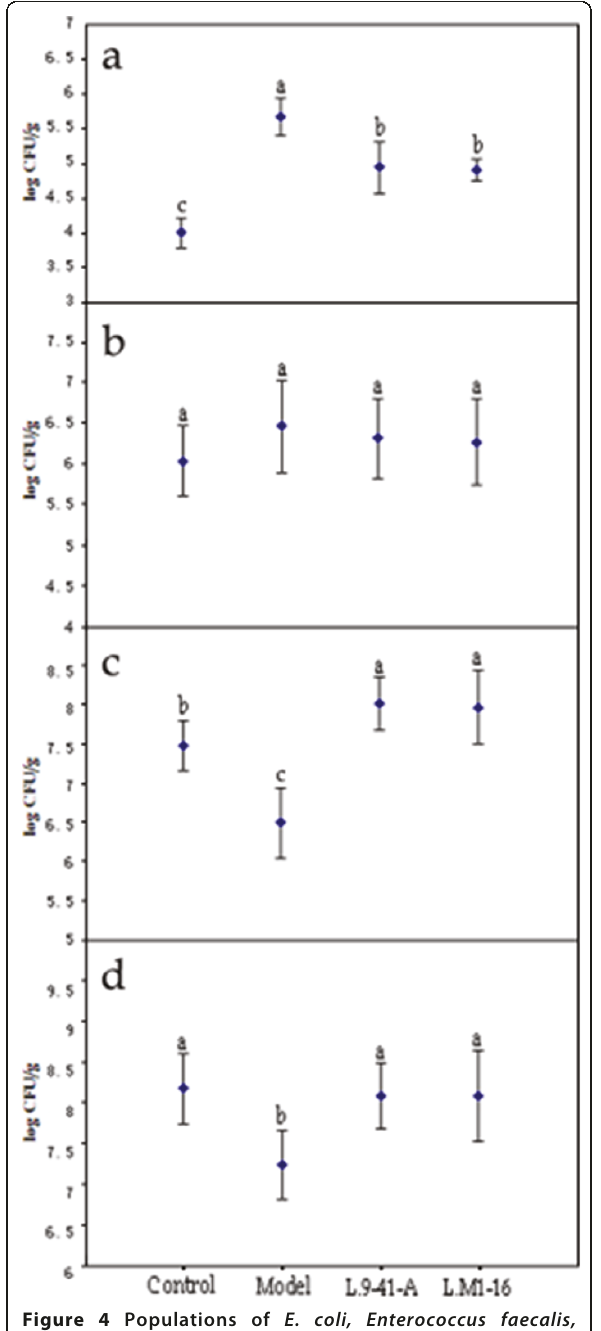
Figure 4 Populations of E. coli, Enterococcus faecalis, Lactobacillus , and Bifidobacterium in rat cecums in the four groups . Control group: normal diet; model group: high-cholesterol diet; L .9-41-A group: high-cholesterol diet + L. plantarum 9-41-A; L . M1-16 group: high-cholesterol diet + L. fermentum M1-16. a: Counts of E. coli colonies. b: Counts of Enterococcus faecalis colonies. c: Counts of Lactobacillus colonies. d: Counts of Bifidobacterium colonies. a,b,c Mean values with different superscript letters differ significantly ( p < 0.05).